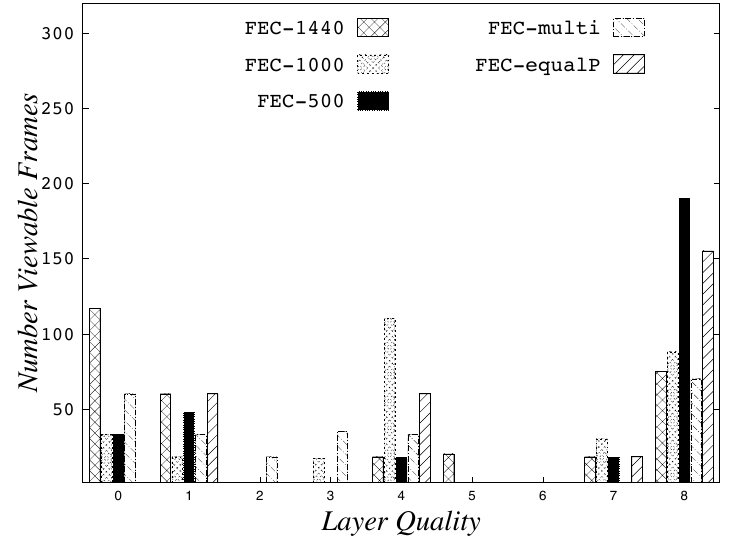
Figure A16. Example of the number of viewable layers for SVC-SC, for each of the FECPacket thres , at a packet loss rate of 10% and a GOP of 16.